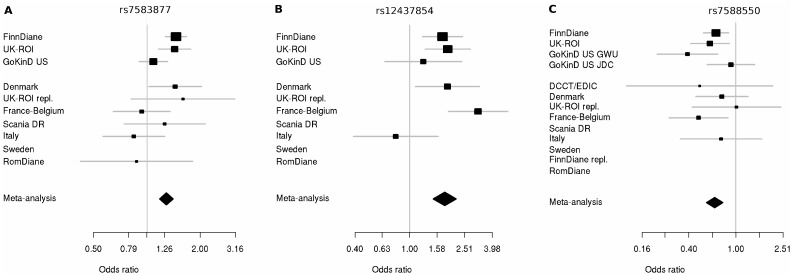
Forest plots for significant hits incorporating discovery and replication plots.Plots show the study-specific association estimates (OR) and 95% confidence intervals for the discovery and second phase studies. (A) Association of rs7583877 with ESRD; heterogeneity P = 0.037. (B) Association of rs12437854 with ESRD; heterogeneity P = 0.046. (C) Association of rs7588550 with DN; heterogeneity P = 0.467. The association estimate and confidence interval for the meta-analysis combining the discovery and second-stage results are denoted by the diamond.